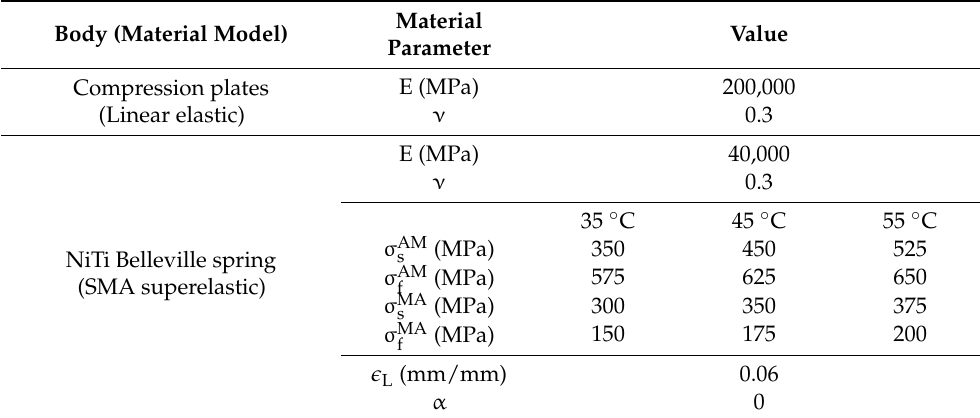
Figure 13. FEA and experimental superelastic response at low loading frequency under controlled temperature. Table 1. Mechanical properties used in FEA.